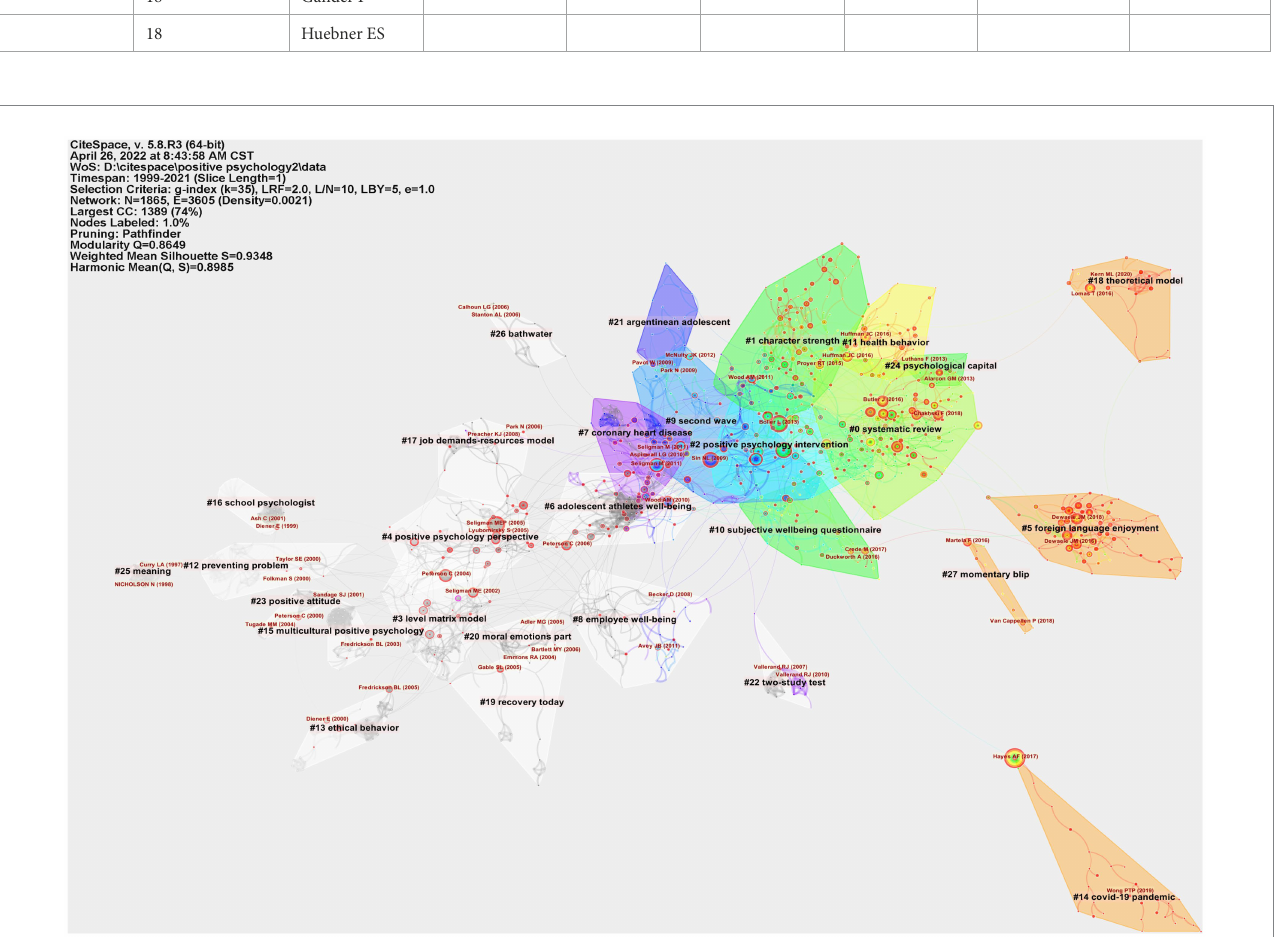
FIGURE 7 Reference co-citation network analysis of publications in positive psychology research. Cluster visualization of the reference co-citation map.